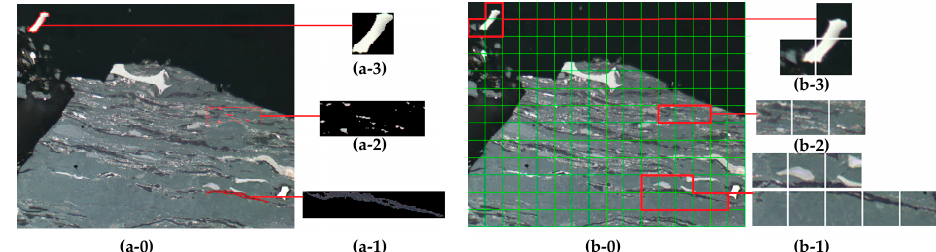
Figure 5. The results of image segmentation based on ( a ) the proposed Maceral Identification strategy based on image Segmentation and Classification (MISC) and ( b ) the fixed-size window strategy. (a-0) and (b-0) denote the original image. (a-1) and (b-1) are the enlargement of sporinites, (a-2) and (b-2) are the enlargement of micrinites, (a-3) and (b-3) are the enlargement of fusinites. Table 4. Comparing the results of random forest and the other 5 machine learning methods for identifying maceral components (10-fold cross-validation, and repeat the experiment 10 times).